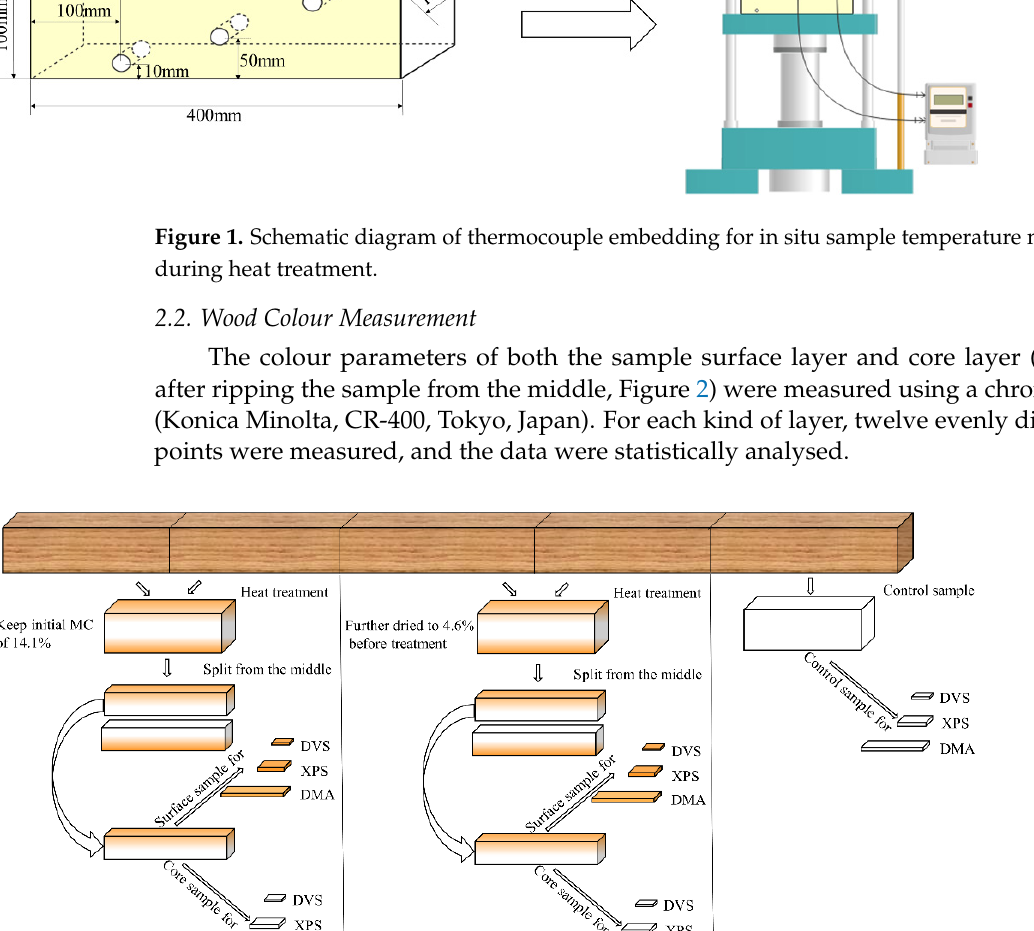
Figure 1. Schematic diagram of thermocouple embedding for in situ sample temperature monitor- ing during heat treatment.